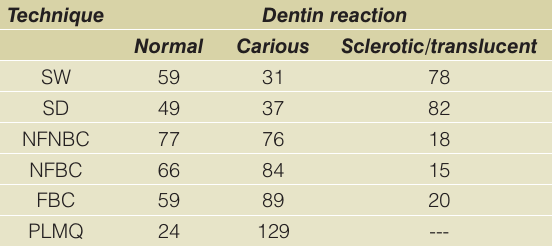
Table 1. Number of dentin reactions detected from each